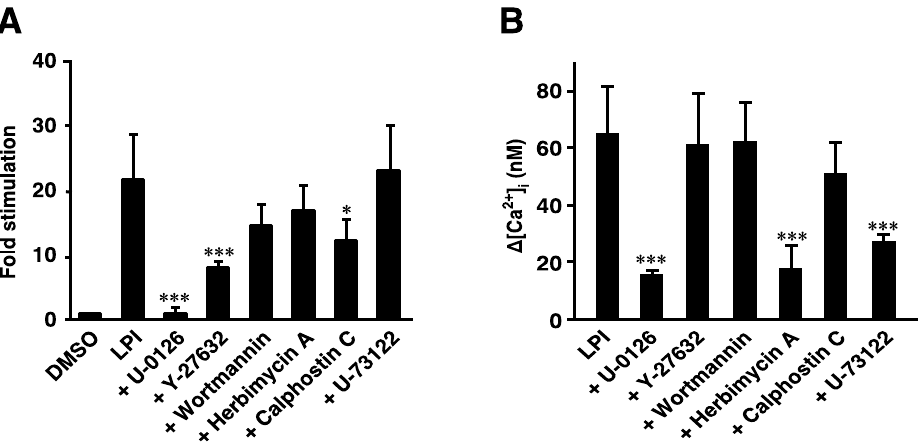
Figure 4. Effects of various inhibitors on the 2-arachidonoyl LPI-induced activation of ERK or increases in intracellular Ca 2+ in GPR55-expressing cells. The 2-Arachidonoyl LPI (1 µM)-induced phosphorylation of ERK ( A ) or increases in intracellular Ca 2+ ( B ) were measured after GPR55-expressing cells were pretreated with the indicated inhibitors. Statistical analyses were performed with one-way analysis of variance (ANOVA), followed by Tukey–Kramer multiple comparison test. The values are means ±SDs of four determinations. * p < 0.05 and *** p < 0.001 versus 2-arachidonoyl LPI alone.